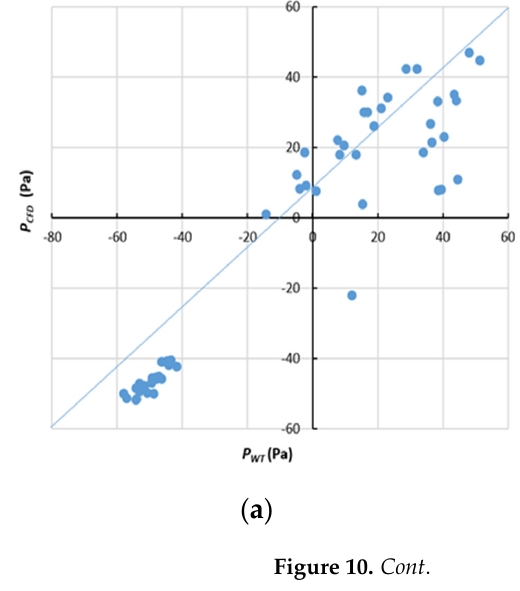
Table 1. Validation metrics calculated for high-rise building with an exoskeleton structure. Validation